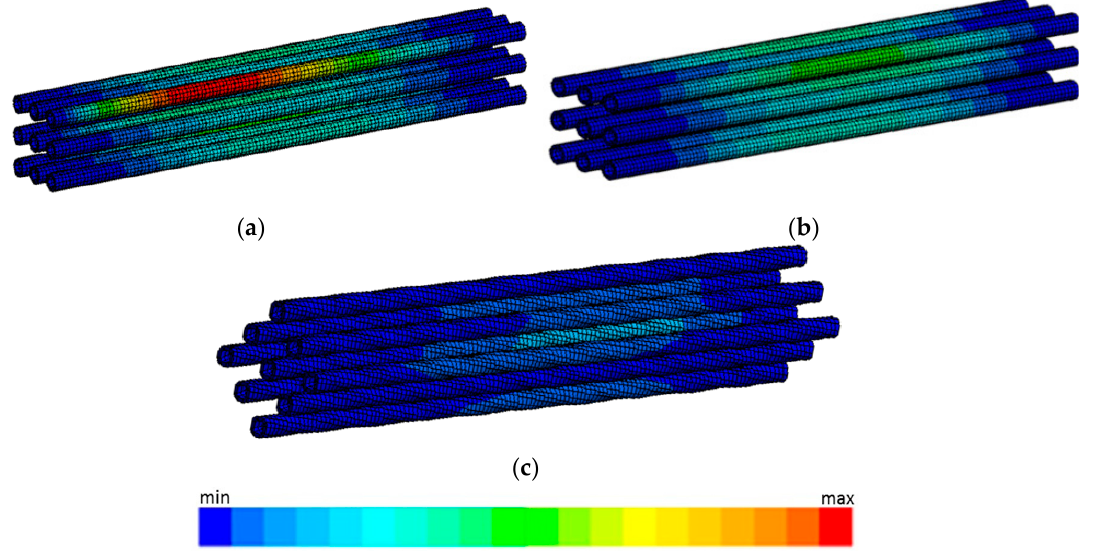
Figure 11. Maximum deformation in tubes at 0.027 kg/s: ( a ) SGCT-STHX; ( b ) HBCT-STHX; and ( c ) CBSTT-STHX.